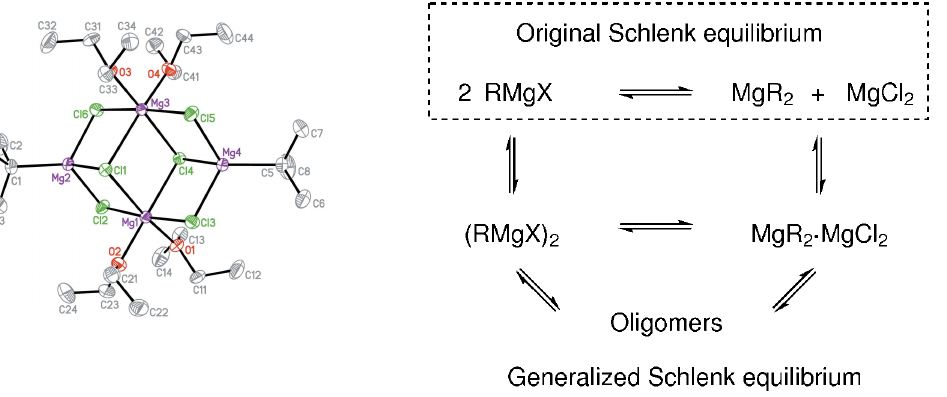
Figure 1 Original and generalized Schlenk equilibrium (solvent molecules neglected; Peltzer et al. ,